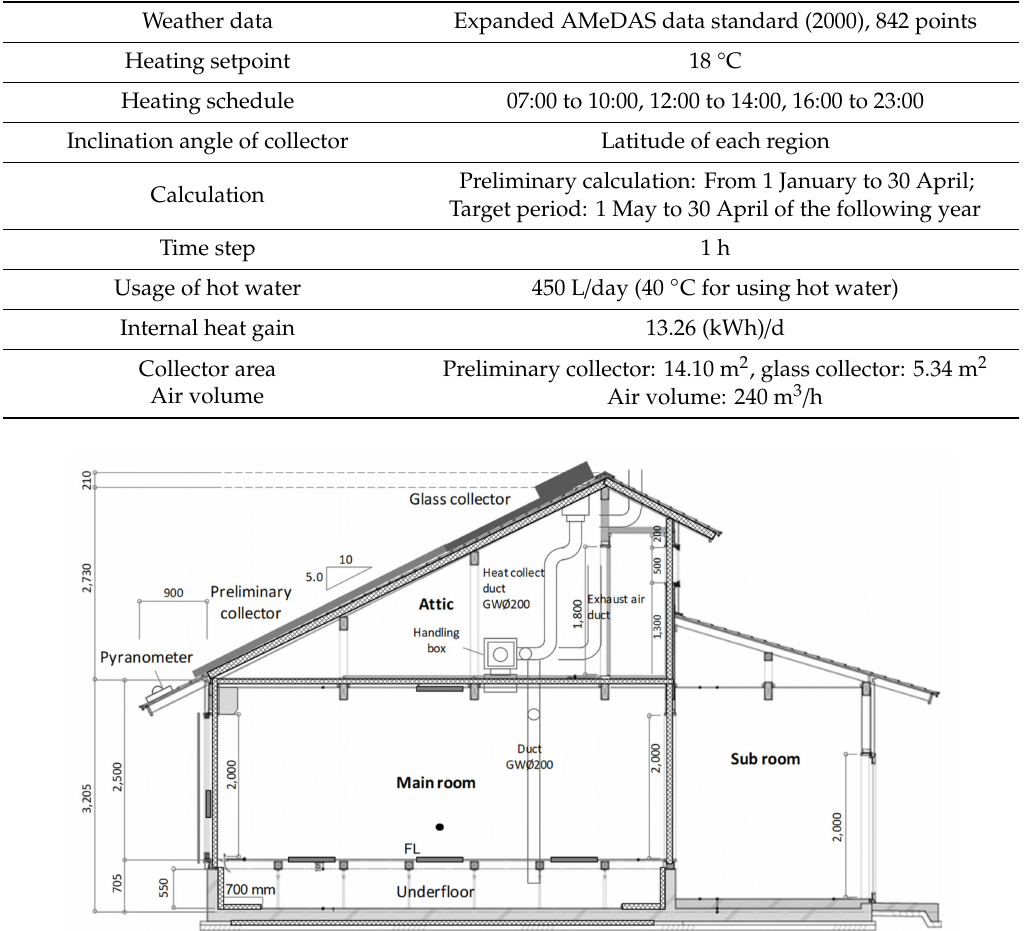
Table 1. Simulation conditions.